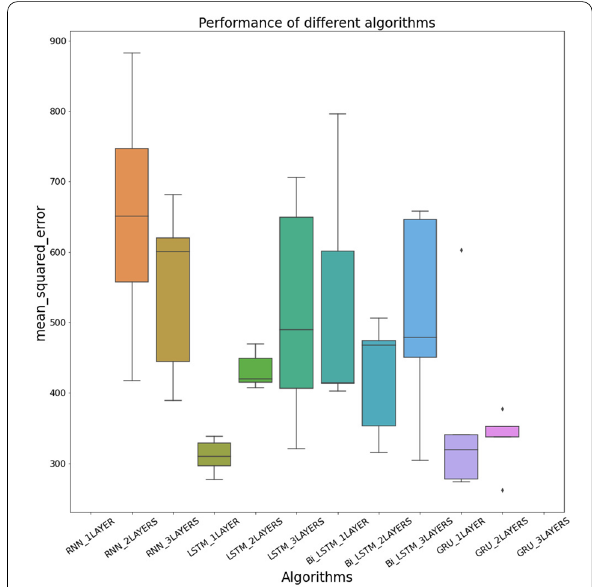
Figure 10 Performance of different algorithms on Dataset FD001, where Optimizer: Adam; Activation function: ReLU; Neuron Number: 128; Sequence Length: 50